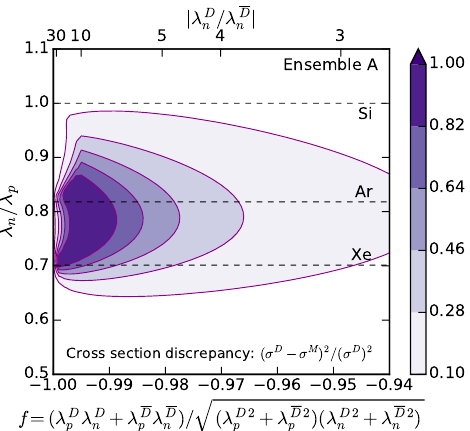
Figure 7 . Analytic cross section discrepancy between Dirac and Majorana DM. Discrepancy (cid:1) (eq. (B.3)) between the DM-Xe cross section expected for a Majorana particle (cid:27) M (estimated from the ‘measured’ DM-Si and DM-Ar cross sections) and for a Dirac particle (cid:27) D (using the ‘true’ coupling